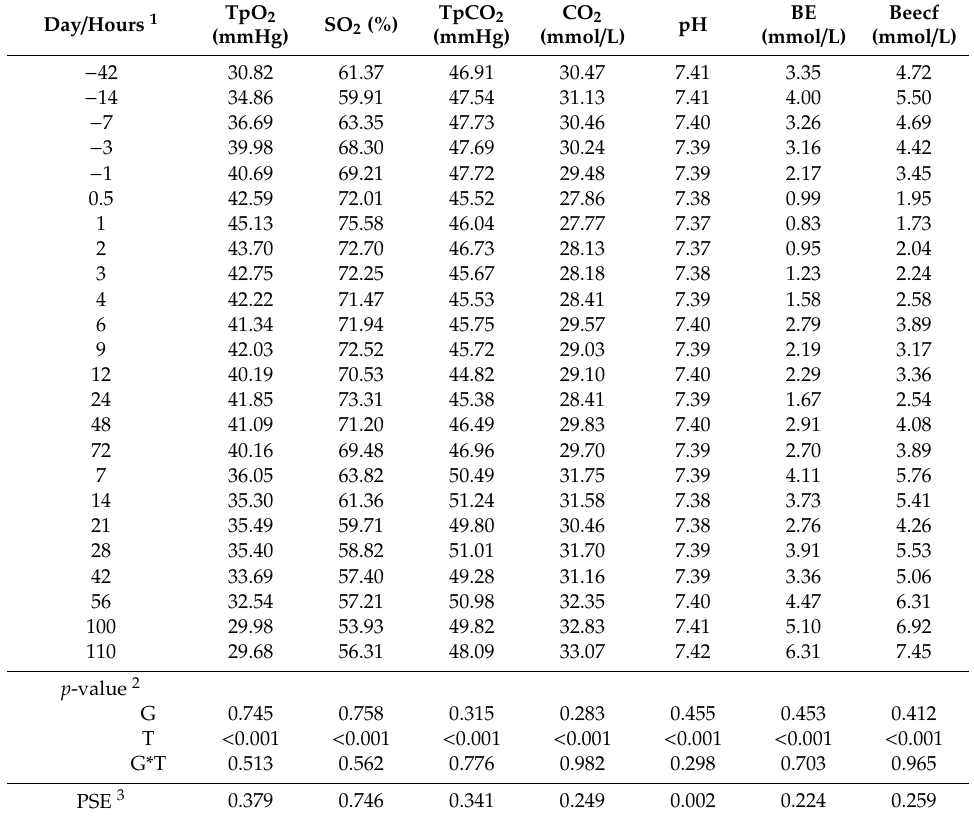
Table A7. E ff ects of L-carnitine supplementation on temperature corrected oxygen and carbon dioxide partial pressure (TpO 2 , TpCO 2 ), oxygen saturation (SO 2 ), total carbon dioxide (CO 2 ), pH in blood and base excess (BE), base excess in extra cellular fluid compartment (Beecf).